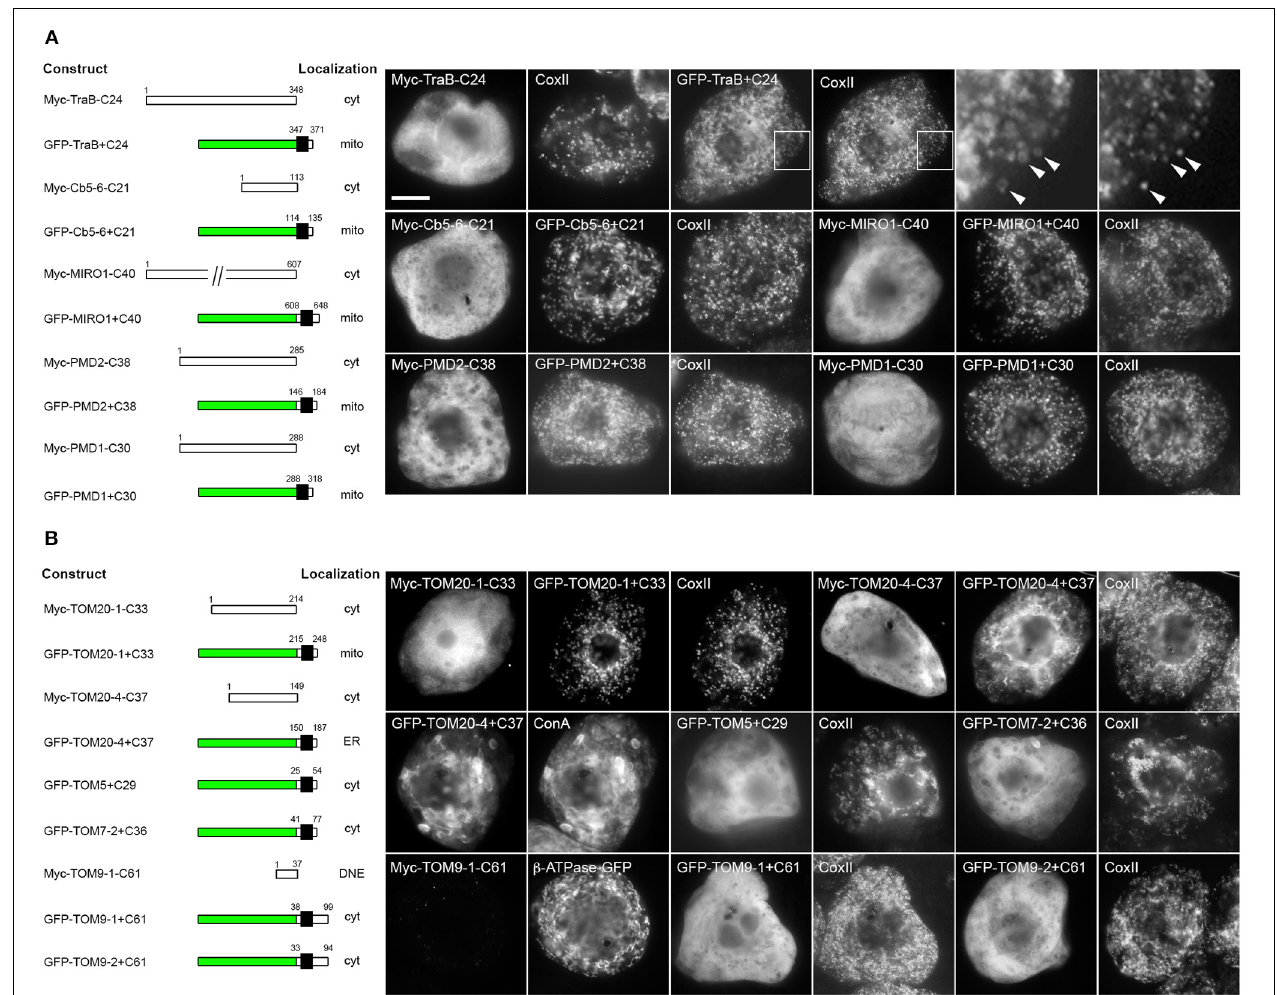
FIGURE 3 | Localization of various C-terminal mutant and GFP fusions of selected mitochondrial-TA proteins in BY-2 cells. Shown on the left in both (A) and (B) are schematic illustrations of various C-terminal-mutant (i.e., truncated) versions or GFP fusions of various dibasic-motif-containing TA proteins (A) or TOM-TA proteins (B) and their corresponding intracellular localization in transformed BY-2 cells. The numbers in the name of each construct denote the number of residues that were either deleted from the C terminus of the Myc-tagged wild-type TA protein or fused to the C terminus of GFP, and the numbers above each illustration correspond to the N- and C-terminal amino acid residues of the TA protein. Portions of the TA protein are represented in the illustrations by white and black boxes, the latter denoting the putative TMD; green boxes denote GFP. Cyt, cytoplasm; DNE, did not express; ER, endoplasmic reticulum; mito, mitochondria. Shown on the right in both (A) and (B) are representative immuno-epifluorescence micrographs illustrating the